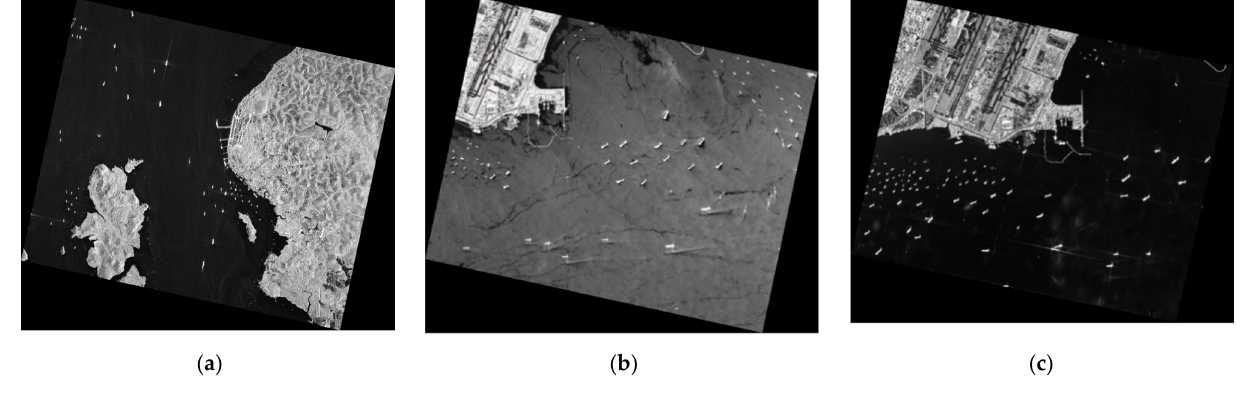
Figure 8. Whole SAR image data, ( a ) data1, ( b ) data2, and ( c ) data3. Table 3. Test data